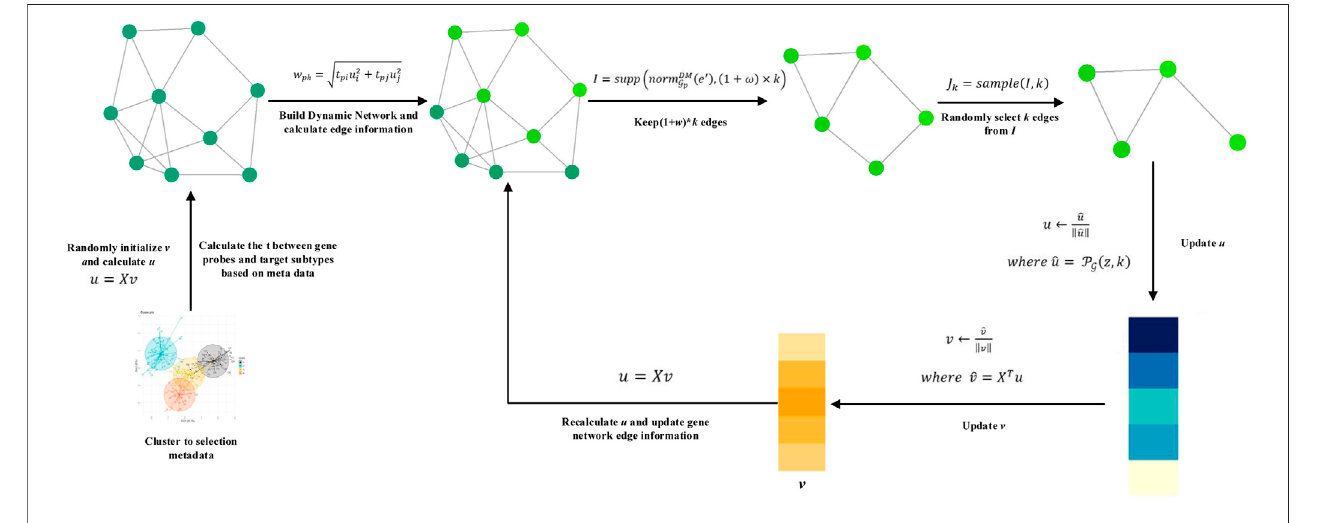
FIGURE 2 | Algorithm of the DM-ESPCA